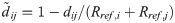
(A) Cartoon illustrating the compression experiment using deformable cells in a capsule to calibrate the center-based model. (A, bottom) Equivalent compression experiment using the center-based model with indication of the maximal principal stress directions of the cells in the capsule during compression using Eq (11). (B) Cartoon showing the volume compartments Vi, Vint and Vcaps in a capsule with thickness H. (C) Average contact force vs. d˜ij=1−dij/(Rref,i+Rref,j) for different K values simulated using DCM (diamonds), and CBM with corrected Hertz contact force (full colored lines) replacing E by E˜, see Eq 14. dij is the distance between the centers of cells i and j, Rref,k the radius of a free cell k ∈ {i, j}. The modified Hertz force shows the same evolution as the force in the DCM, while an uncorrected Hertz force (gray line, Eq 6) strongly underestimates the interaction force for strong volumetric compression. (D) Pressure curves during compression of the spheroid as a function of the inter-cellular volume fraction simulated with the DCM and the CBM with modified Hertz force using here K(V). The pressure for CBM was computed using both the capsule pressure and average virial stress per cell calculated from Eq (11). A representative movie (S3 Video) of these simulations is provided).